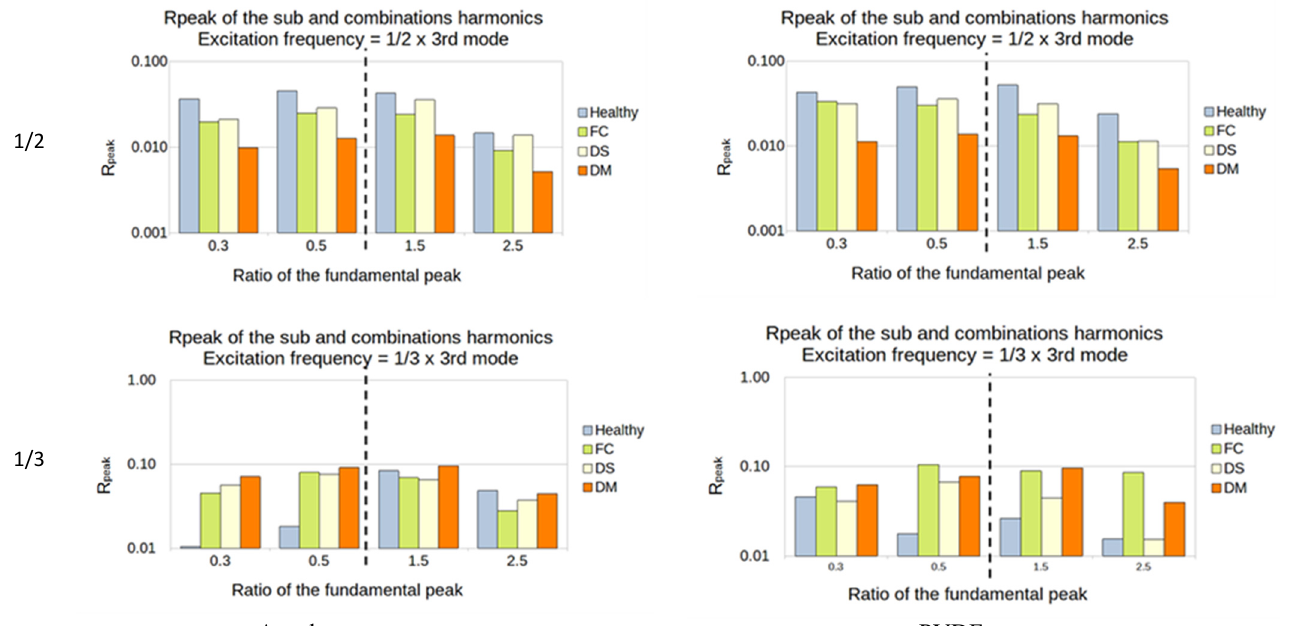
Figure 18. Third natural frequency and its ratio of 1, 1/2, and 1/3 as the frequency of excitation.